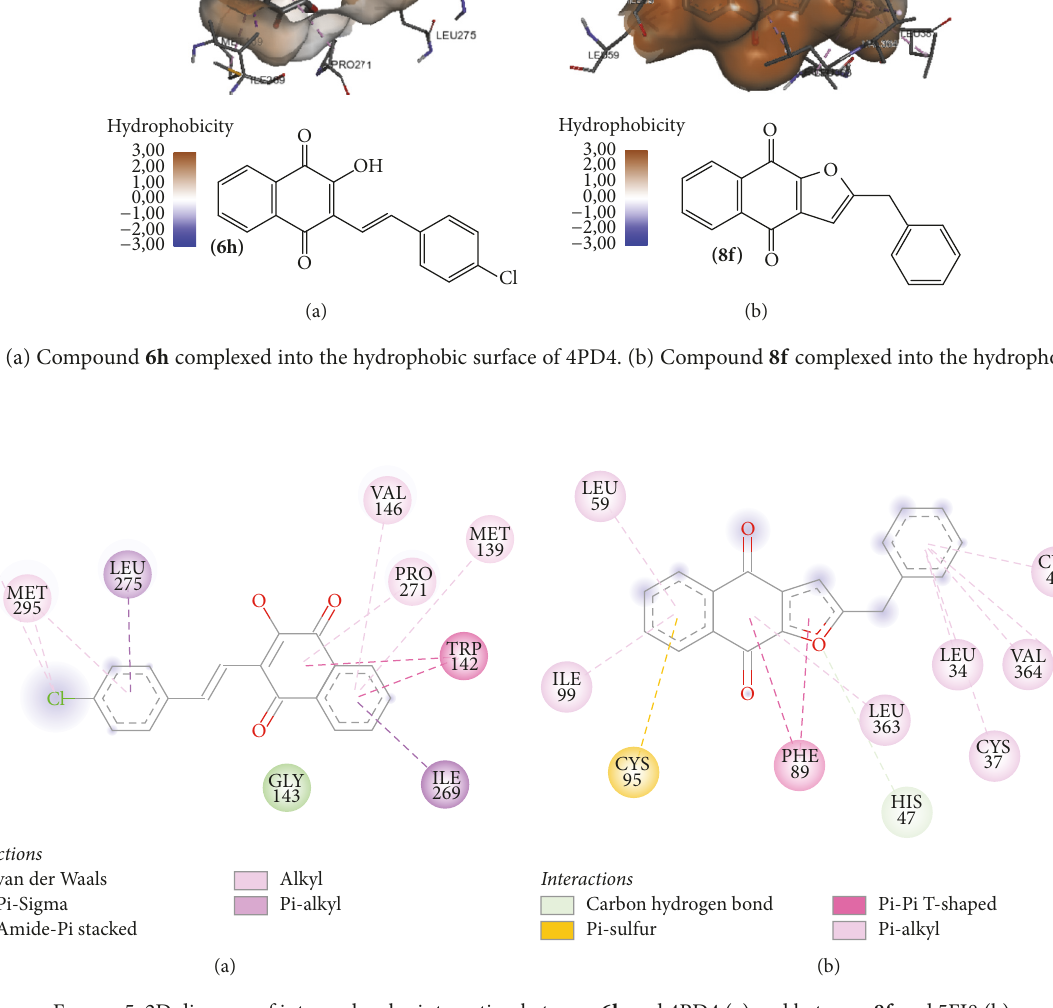
Figure 5: 2D diagram of intermolecular interaction between 6h and 4PD4 (a) and between 8 f and 5FI8